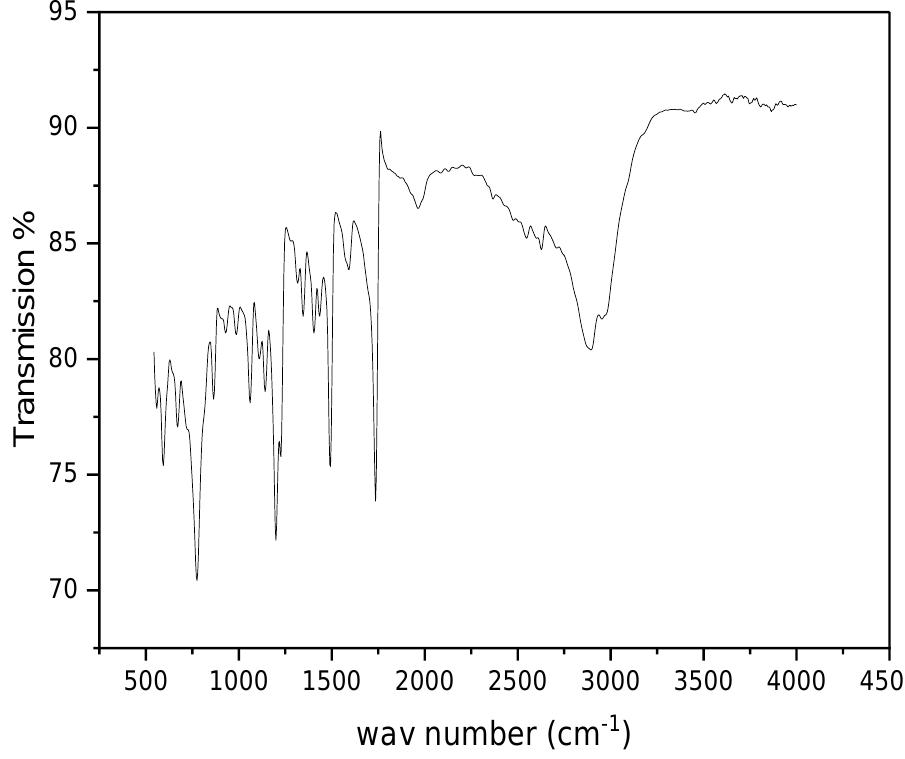
Figure 2: The FTIR spectrums for PANI- Fe